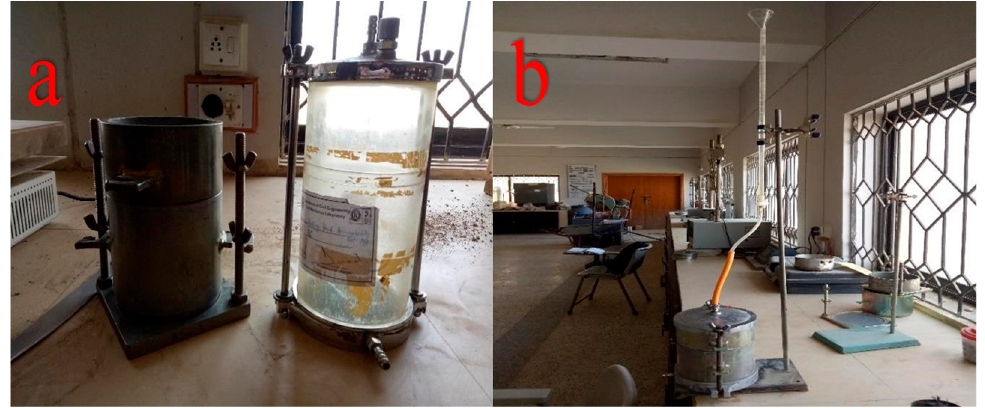
Figure 1. ( a ) Permeability apparatus and ( b ) modified permeability apparatus.